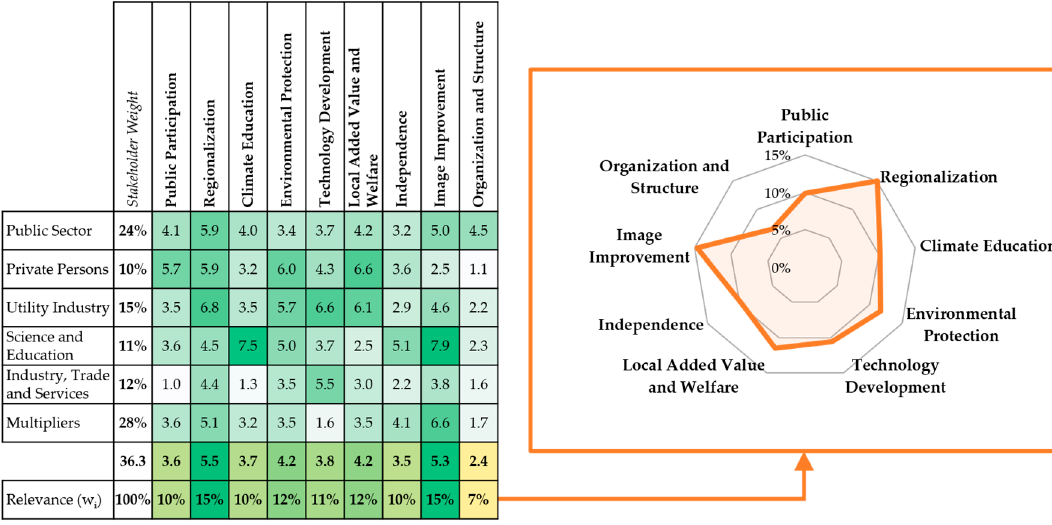
Figure 5. Fillet-in HomE: stakeholder results by stakeholder groups and weighting vector 𝑤(cid:4652)(cid:4652)⃗ (cid:3036) for the investigated municipality in a radar chart.